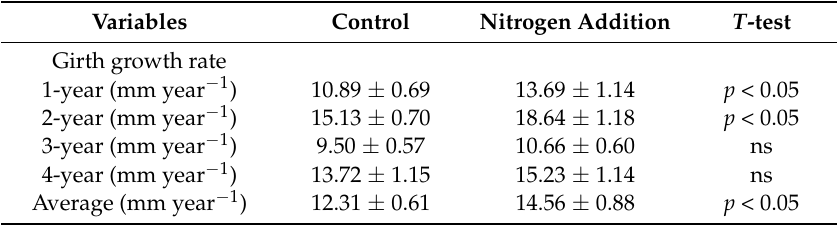
Table A2. Girth growth rates at breast height in the Chinese fir forest plantation in the nitrogen addition treatment and control from 2012 to